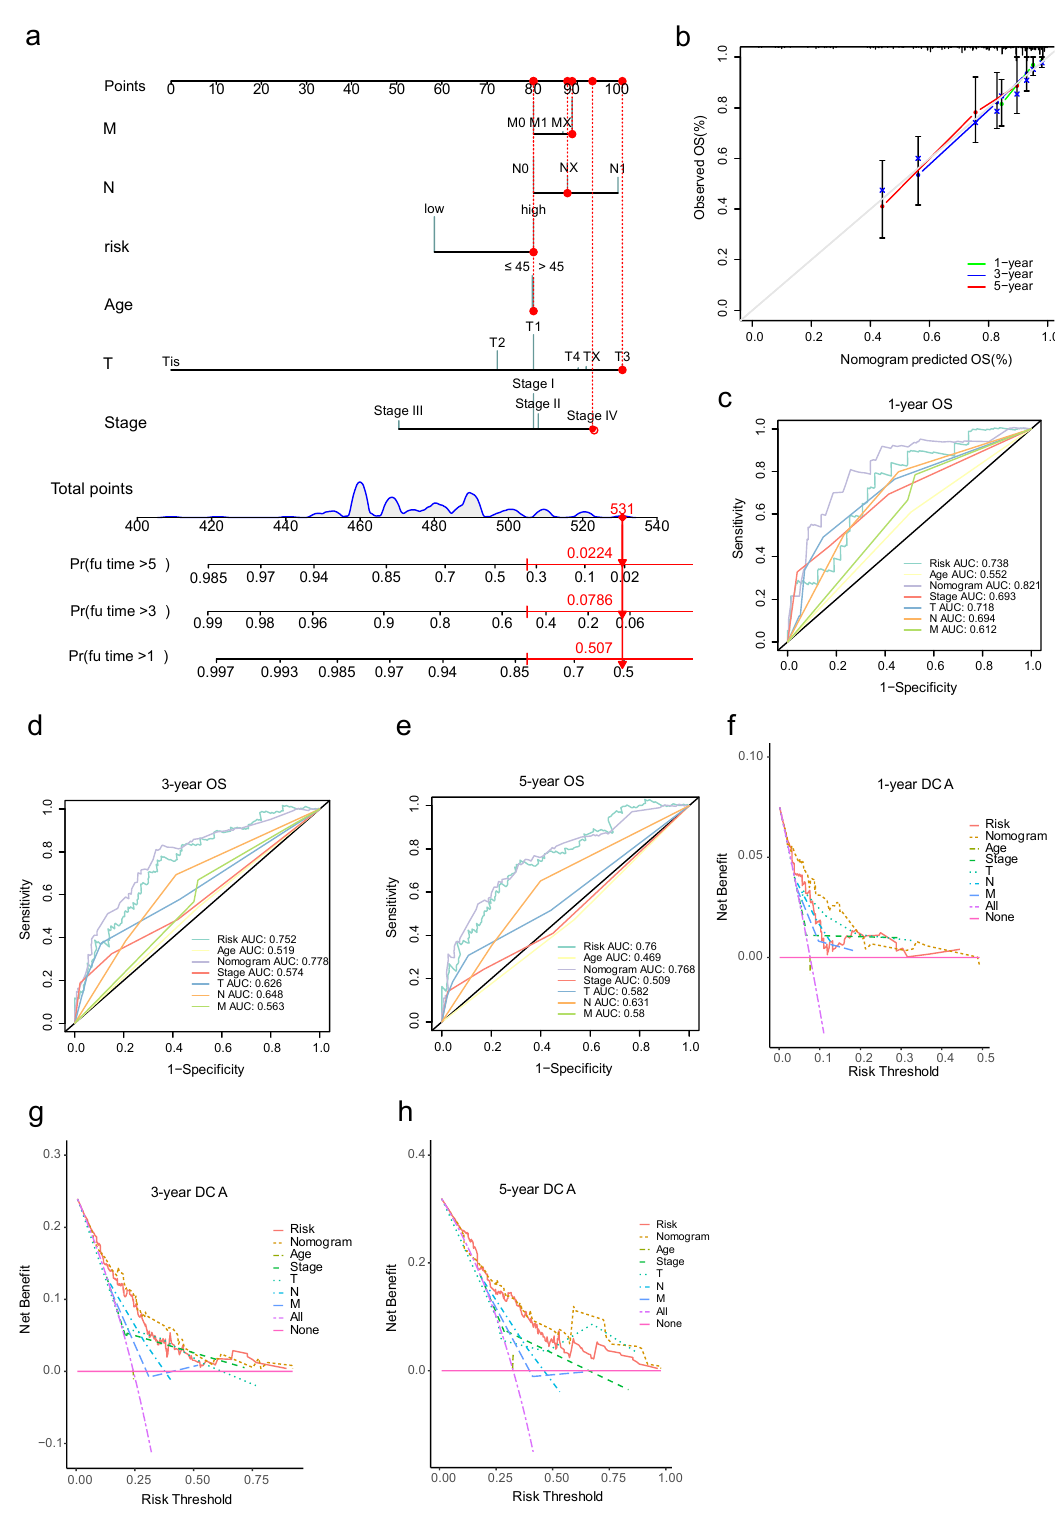
Figure 8. Development and validation of the nomogram model for the prognosis of cervical cancer. ( a ) Scoring system of the nomogram model, where red dots indicate the scores of each index, total score, and predicted survival probability for patient number 4; ( b ) calibration curves of the nomogram model; ( c – e ) ROC curves of the 1-year, 3-year, and 5-year OS rate predictive validity of the nomogram model and other independent predictors; ( f – h ) clinical decision curves for the 1-year, 3-year, and 5-year OS rates using the nomogram model and other independent